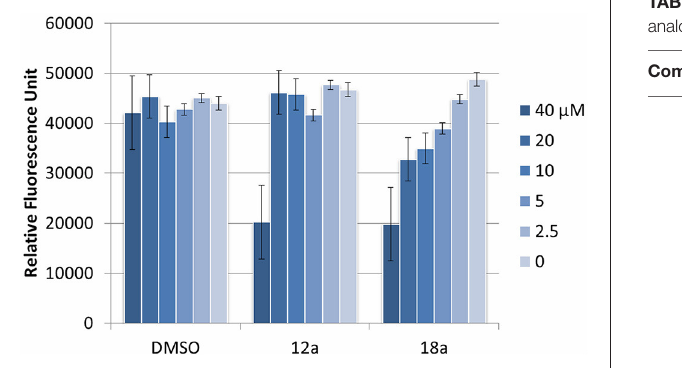
FIGURE 6 | Cytotoxic effect of compounds 12a and 18a on murine macrophages. DMSO was used as vehicle control. Compounds were tested at various concentrations (40 µ M and subsequent 2x dilution). Experiments were done in triplicate manner (technical and biological replicates). Error bars are means ± SDs.